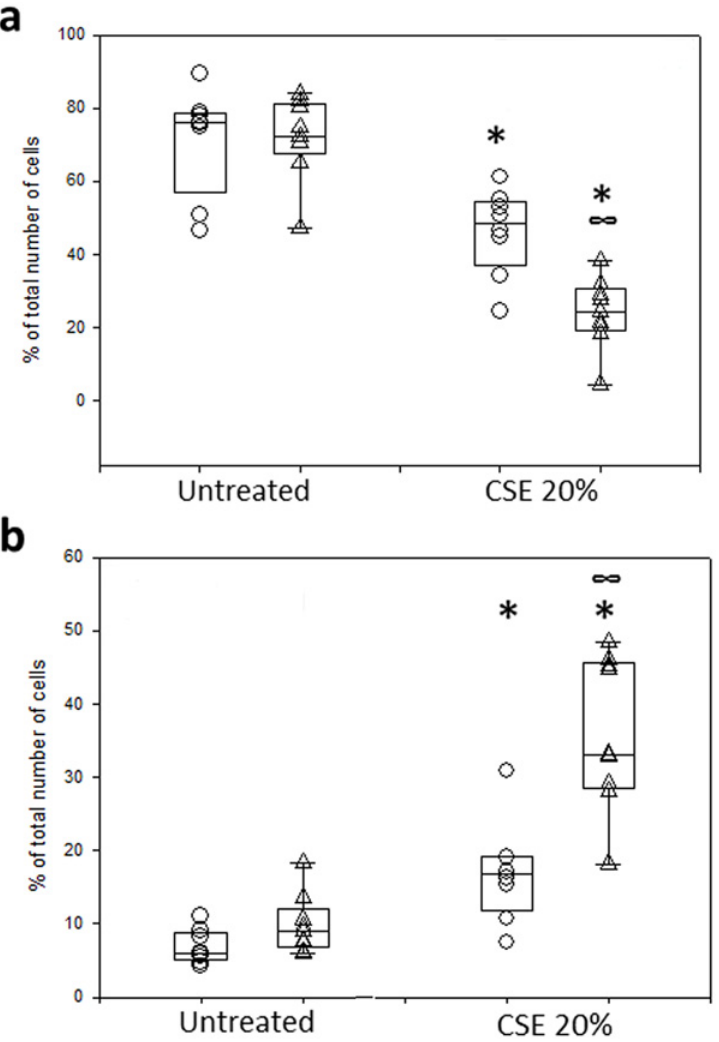
Fig 2. Effect of CSE on PBEC Viability and Apoptosis. PBEC obtained from non-asthmatic and asthmatic donors were treated for 24h with 20% CSE. Cell viability (a) and early apoptosis (b) were then evaluated with AnnexinV staining. The results are displayed as a box plot showing median, interquartile range and 5 – 95% confidence intervals using PBECs from 10 non-asthmatic ( (cid:1) ) and 10 asthmatic ( Δ ) volunteers. * represents significance (p < 0.05) according to Wilcoxon Signed Rank tests comparing treatment with untreated control. 1 represents significance (p = 0.003) according to a Mann Whitney U test comparing CSE treatment between PBECs from non-asthmatic and asthmatic